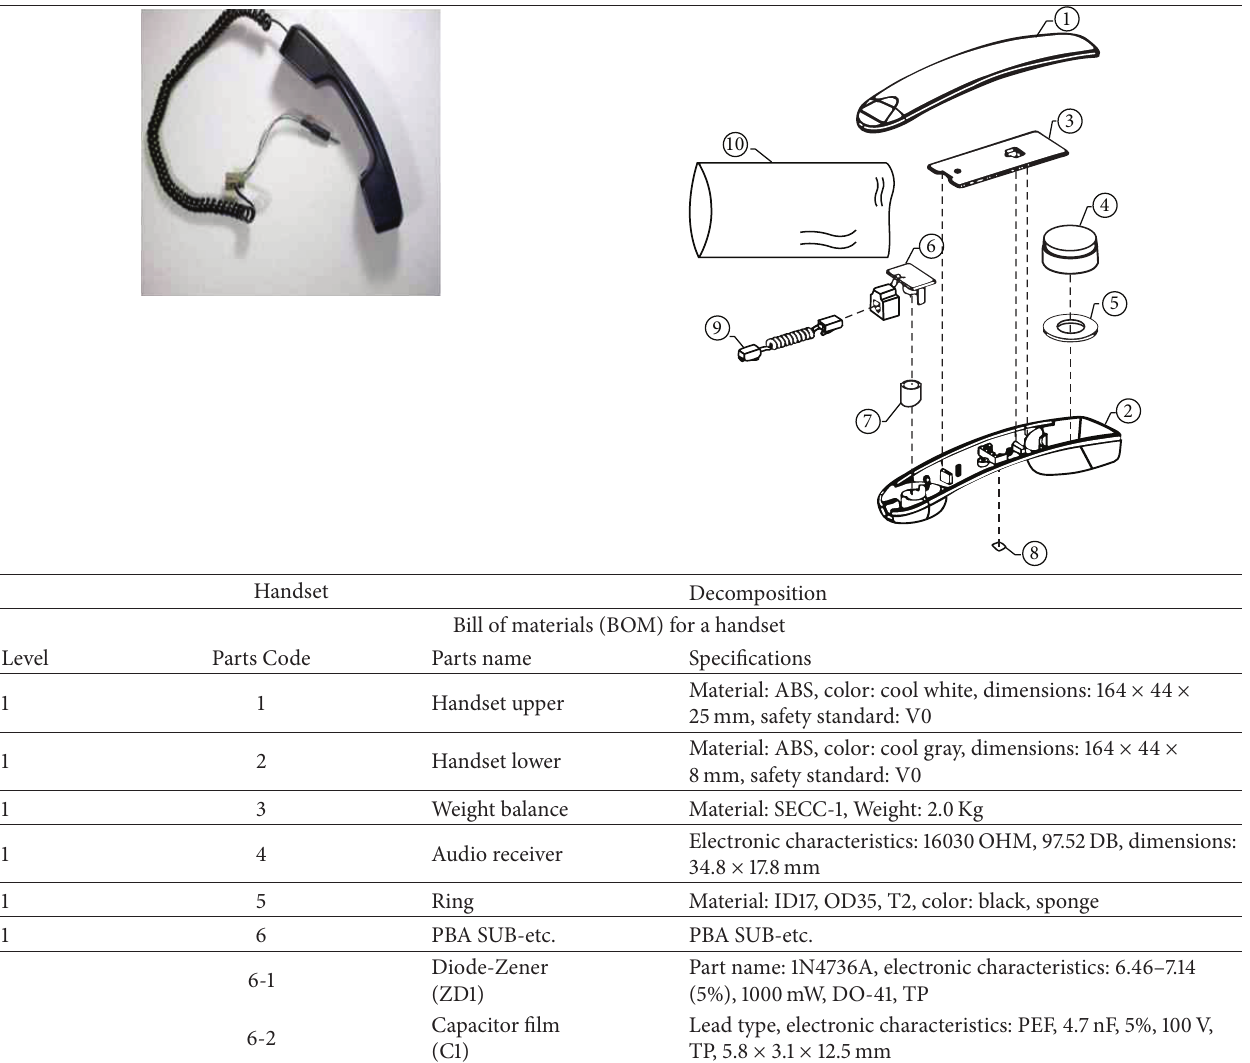
Table 10: Schematic drawing of a handset &